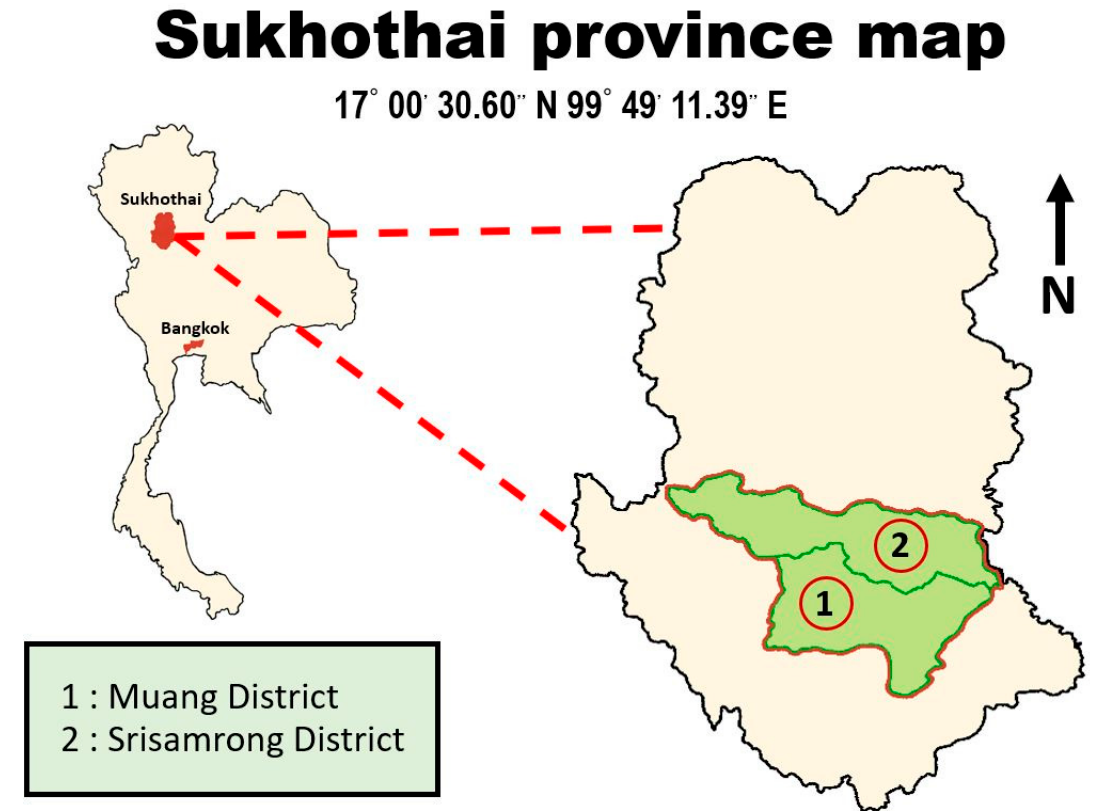
Figure 2. Study area: Sukhothai province (with two districts with Burley tobacco farming) .